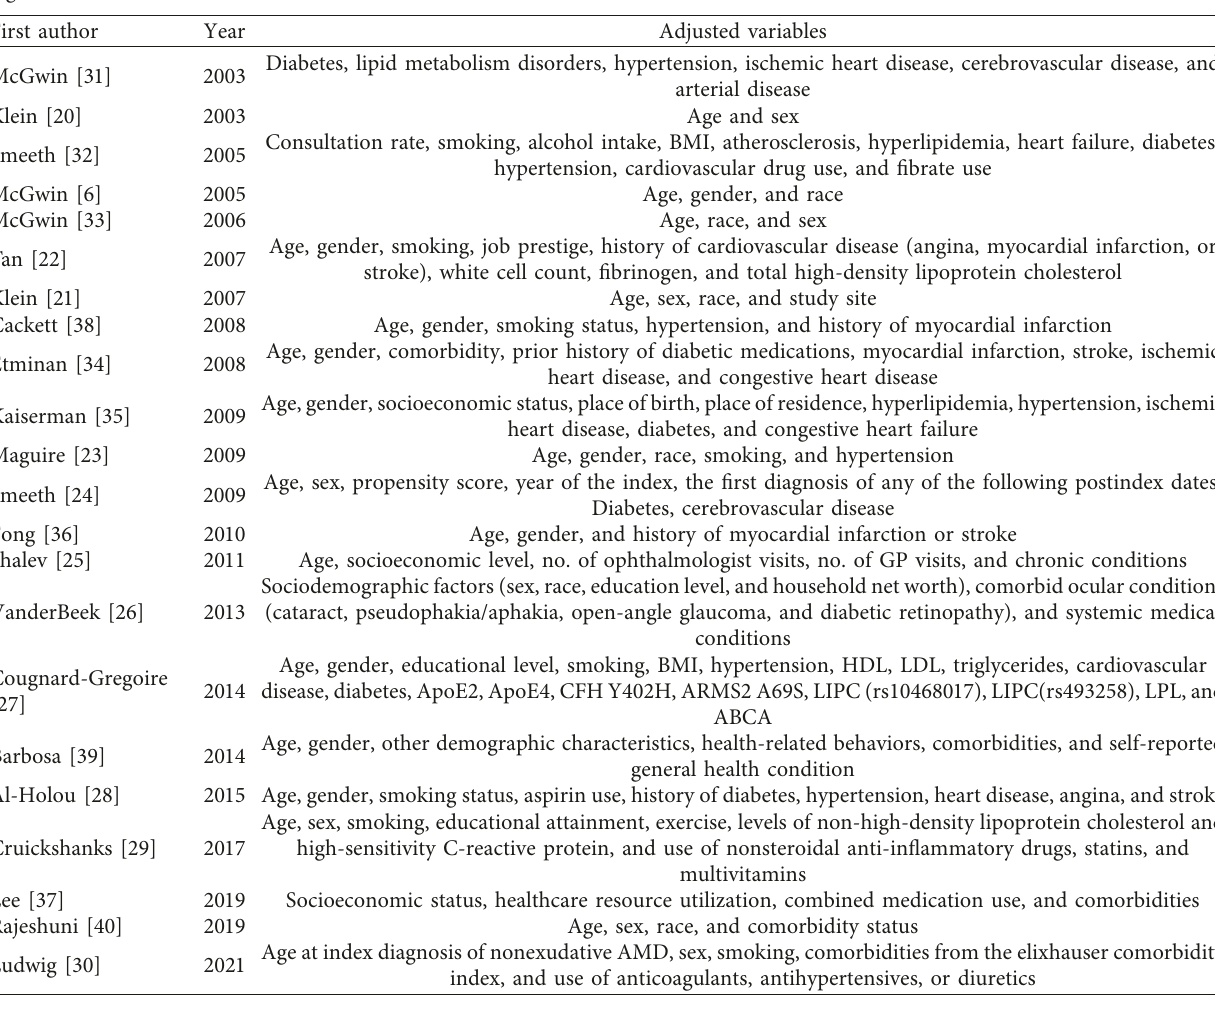
Table 2: Adjusted variables in the assessment relationship between statin consumption and the risk of developing age-related macular